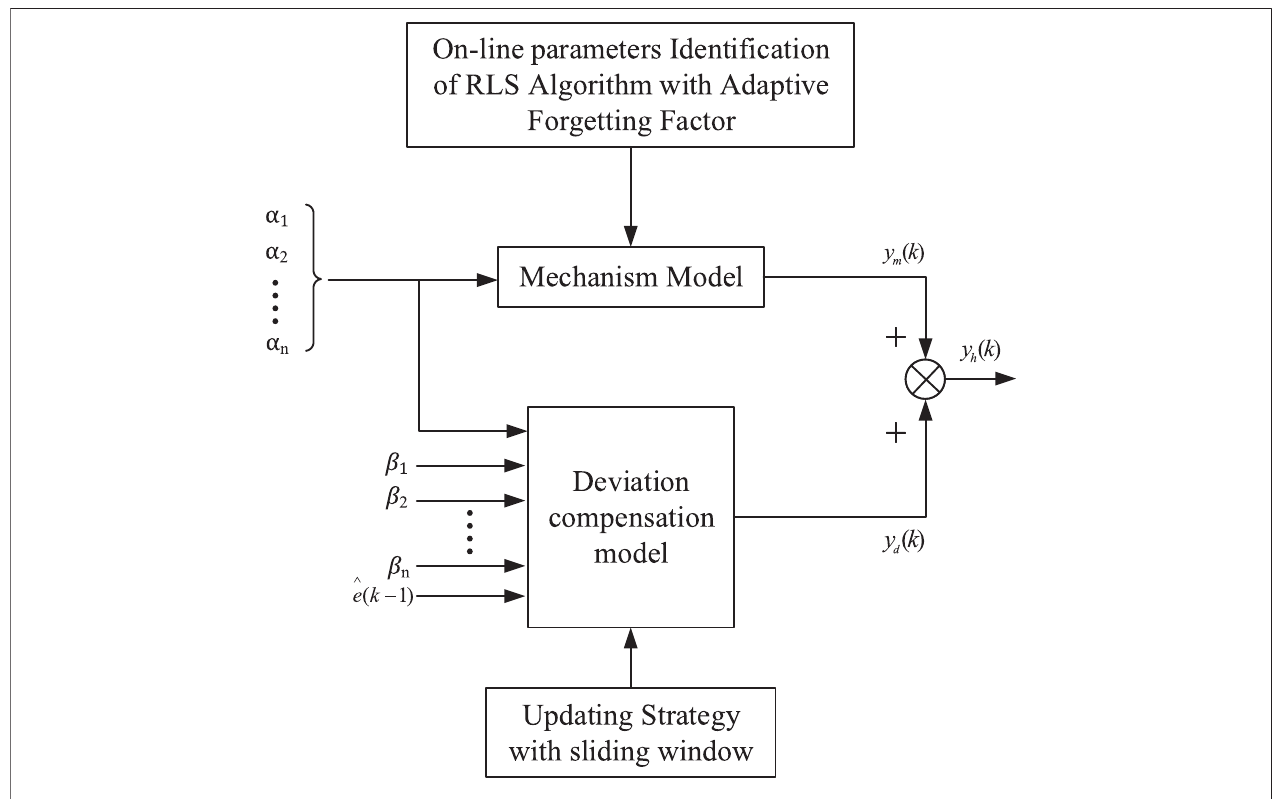
FIGURE 1 | The structure of adaptive hybrid